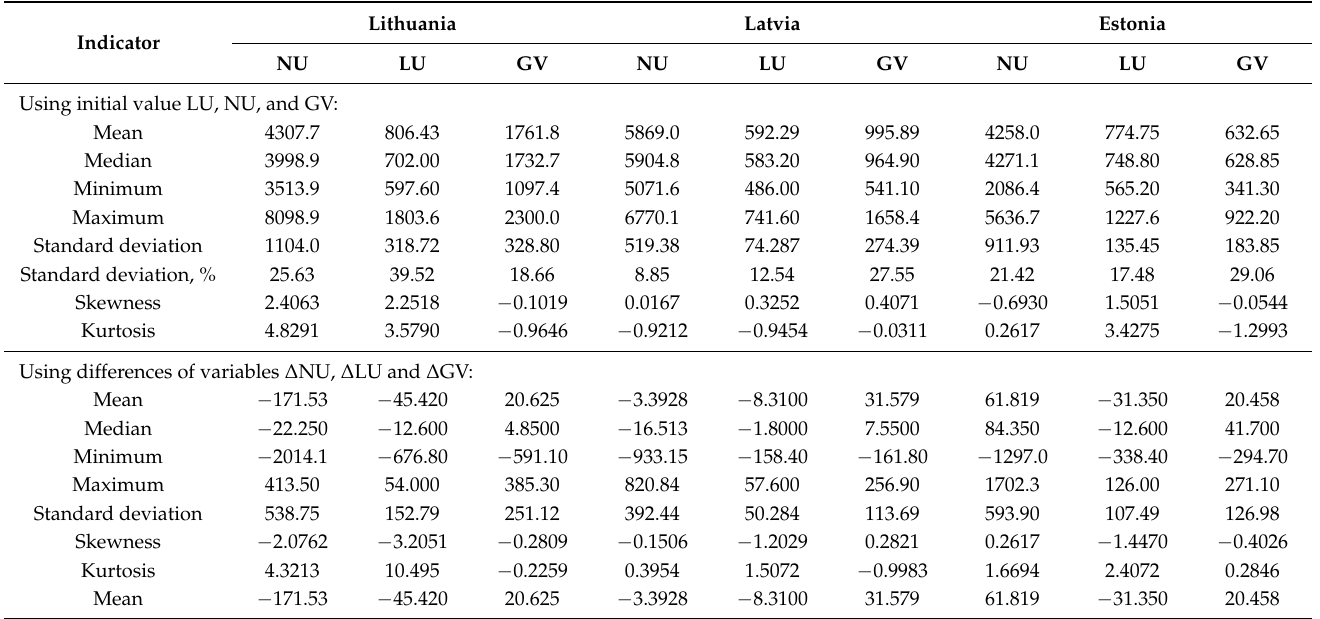
Table 1. Descriptive statistics of total energy use by agriculture (NU), electricity use by agriculture (LU), and gross value added generated by agriculture (GV).